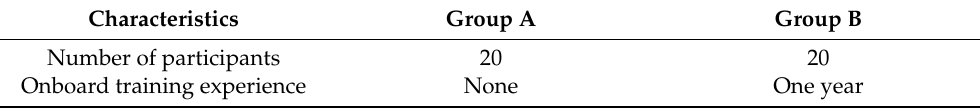
Table 1. Participants’ information.